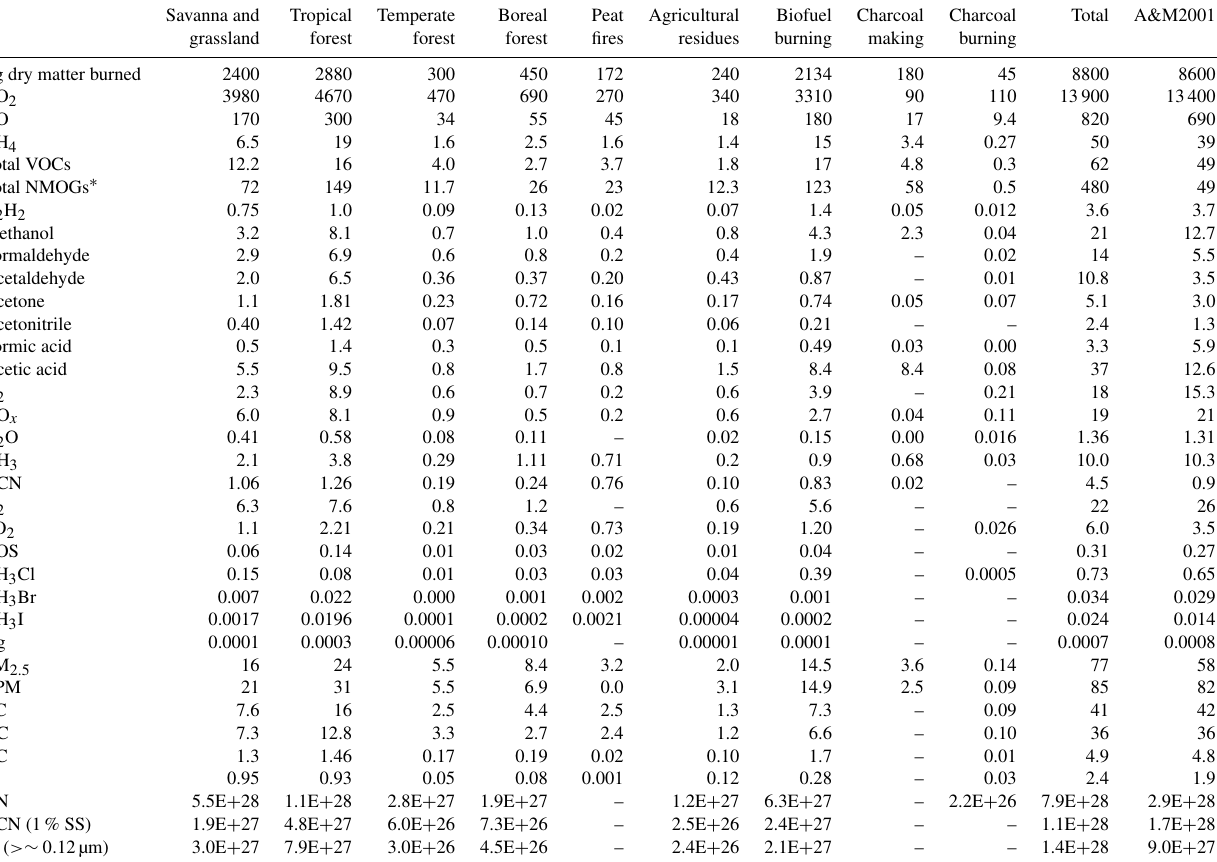
Table 3. Global emission of selected species based on the emission factors in Table 1 and the biomass burning estimates in Table 2 (Tga − 1 ). Savanna and Tropical Temperate Boreal Peat Agricultural Biofuel Charcoal Charcoal Total A&M2001 grassland forest forest forest fires residues burning making burning Tg dry matter burned